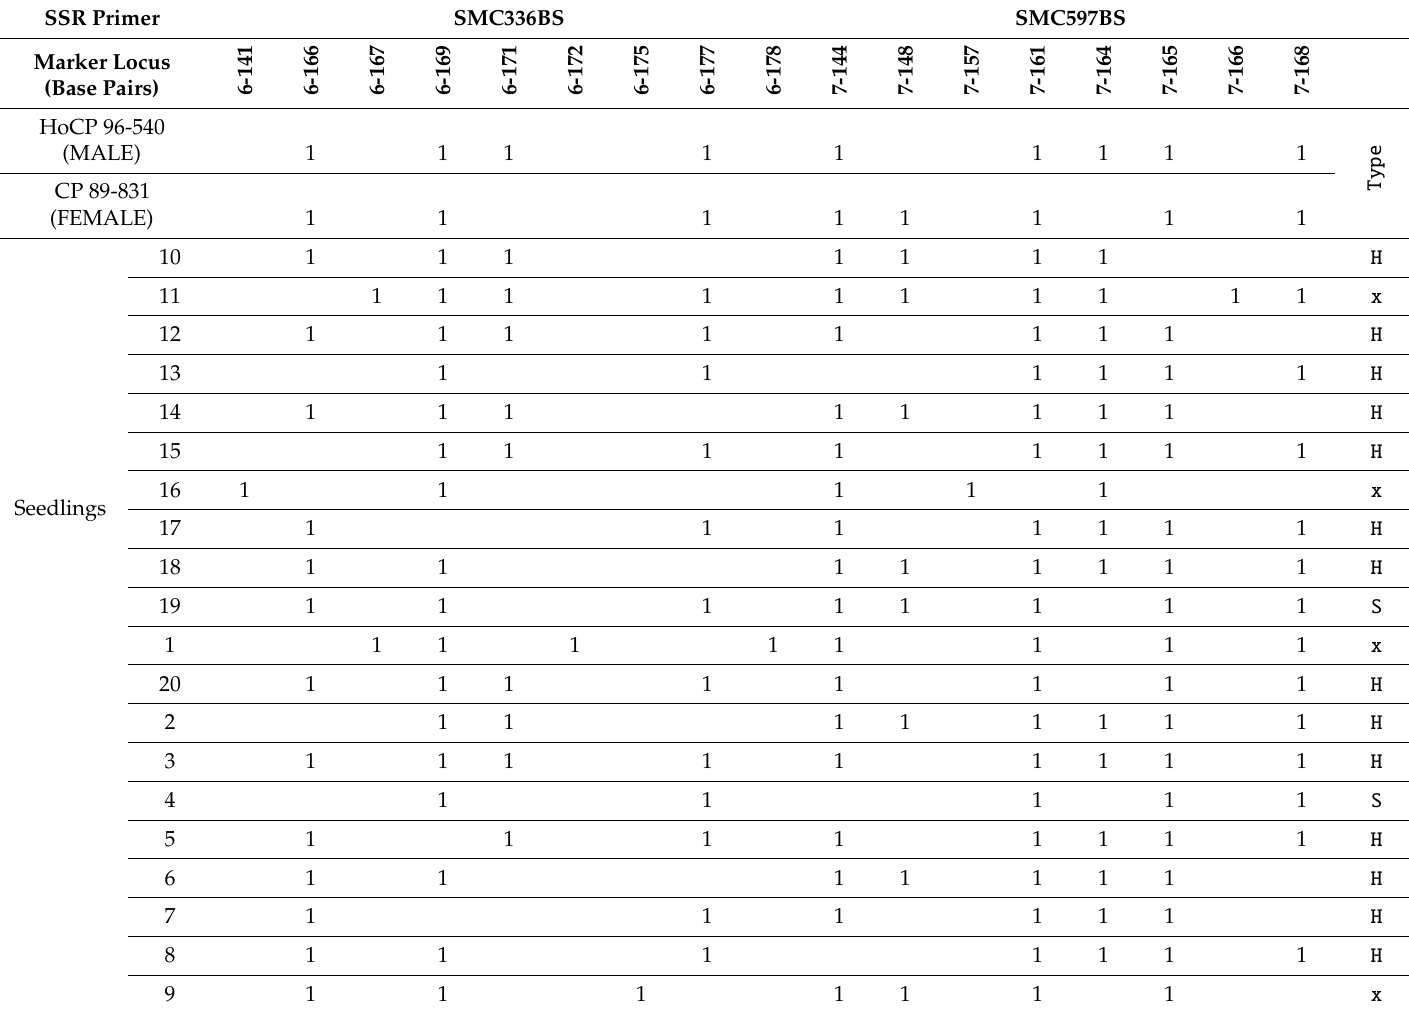
Table 2. Identification of Cross HB 04-3305 using SSR markers. Three types of progeny were identified from the Cross HB 04-3305, the first type is hybrid (H), the second type is self (S), the third type is o ff -type